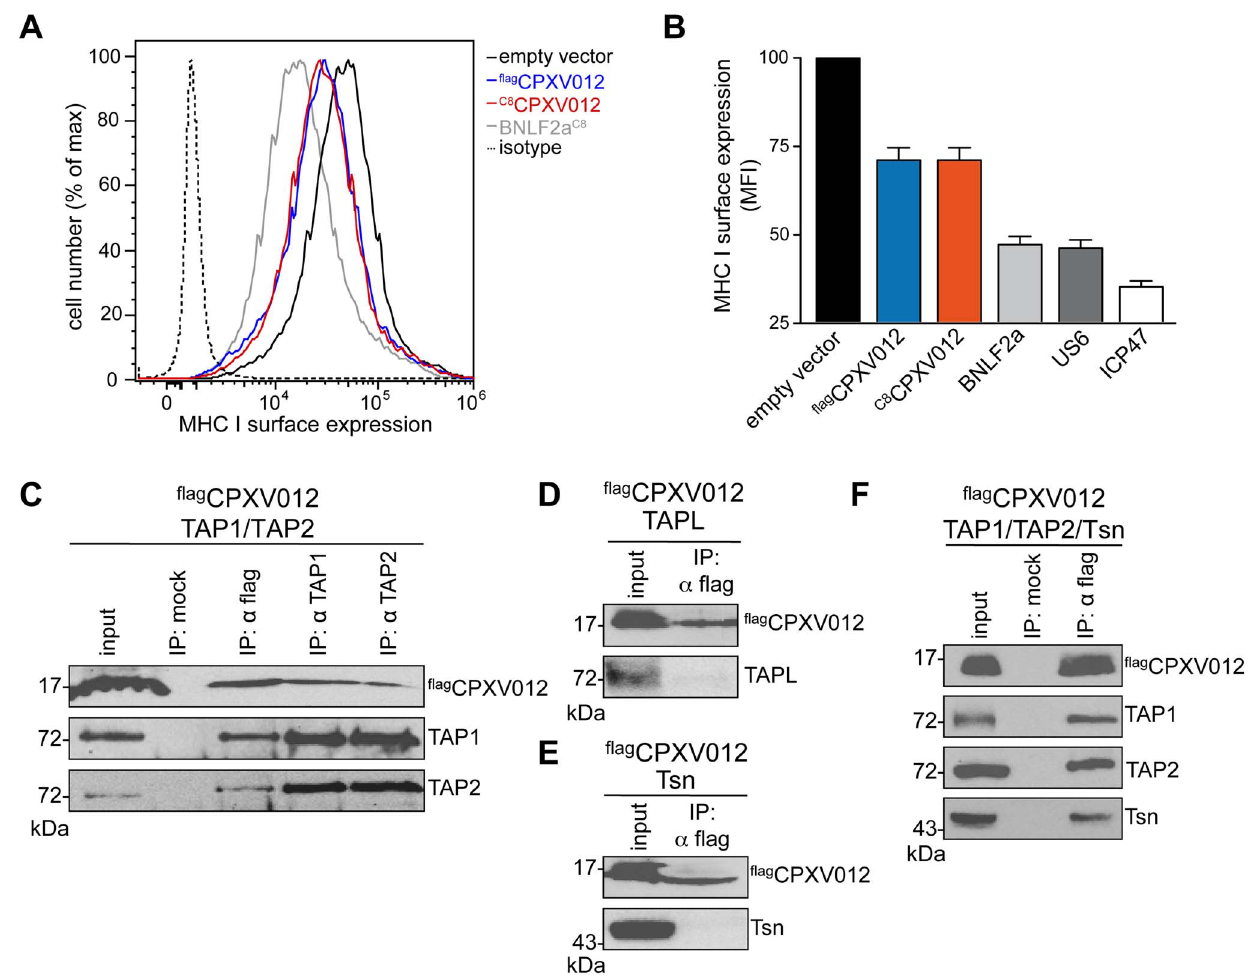
Fig. 1. CPXV012 inhibits MHC I antigen presentation by targeting TAP directly. (A) Down-regulation of MHC I surface expression by CPXV012. HeLa cells were transiently transfected with empty vector, flag CPXV012, C8 CPXV012, BNLF2a C8 , US6 myc or ICP47 in pIRES2-EGFP, respectively. For clarity, US6 and ICP47 are summarized only in panel B. Peptide-loaded MHC I molecules at the cell surface were analyzed by flow cytometry. Only GFP-positive cells were analyzed; isotype control (dotted line). (B) Evaluation of the histograms from A. Mean fluorescence intensity (MFI) was calculated for cells transfected with the indicated constructs. (C–F) CPXV012 binds directly to TAP. flag CPXV012 was coexpressed with TAP1/2 (C), TAPL (D), Tsn (E), or TAP1/2 and Tsn (F) in Sf 9 cells. Proteins were immunoprecipitated with TAP1 (mAb 148.3), TAP2 (mAb 435.3), or flag-specific antibodies (IP). The HC10-antibody was used as negative control (mock). Samples were analyzed by immunoblotting with the corresponding antibodies. An aliquot (1/20) of the crude membrane input is